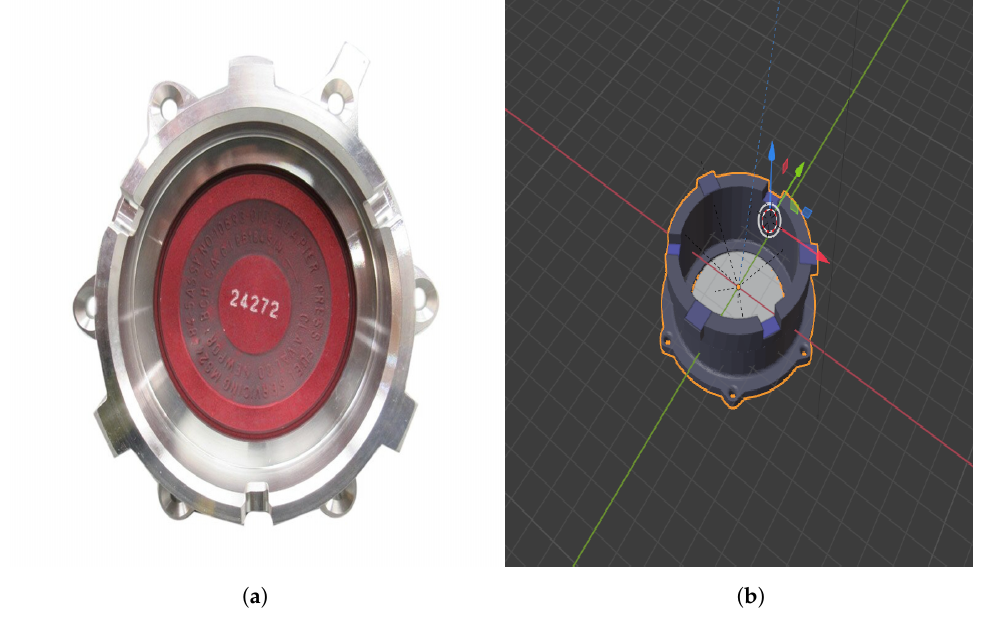
Figure 1. Main Elements of Hybrid Dataset. ( a ) Pressurised Refuelling Adaptor [29]. ( b ) 3D Design of Refuelling